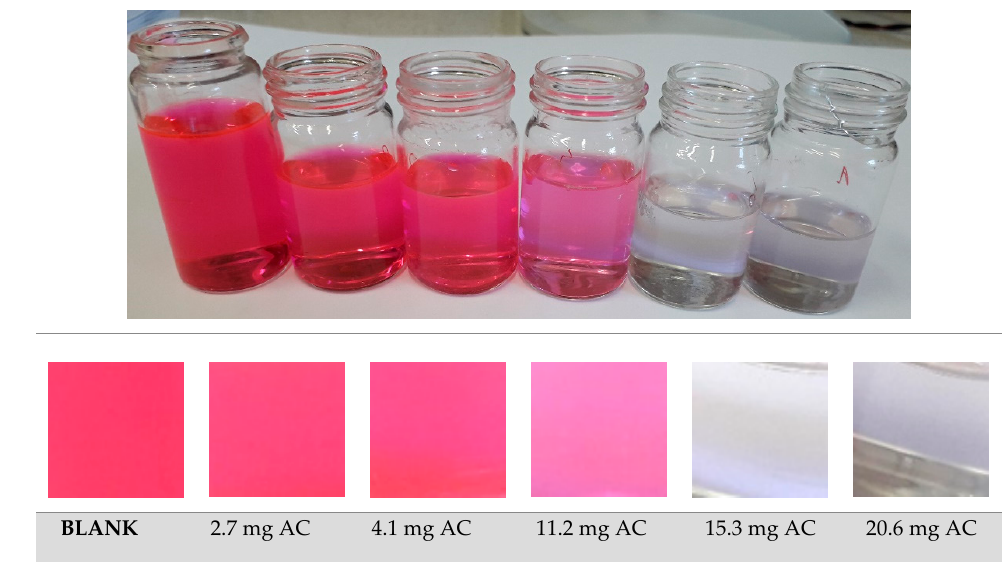
Figure 5. Discoloration of the RhB solution by the application of the activated carbon obtained by the pyrolysis of the straw pellet and chemical activation with KOH (the sample to KOH mass ratio of 1:2). The numbered pictures represent various dosages of activated carbon: no. 2–6 depict 2.7, 4.1, 11.2, 15.3 and 20.6 mg, respectively, used for sorption of 30 mg / dm 3 of Rhodamine B at 25 °C.